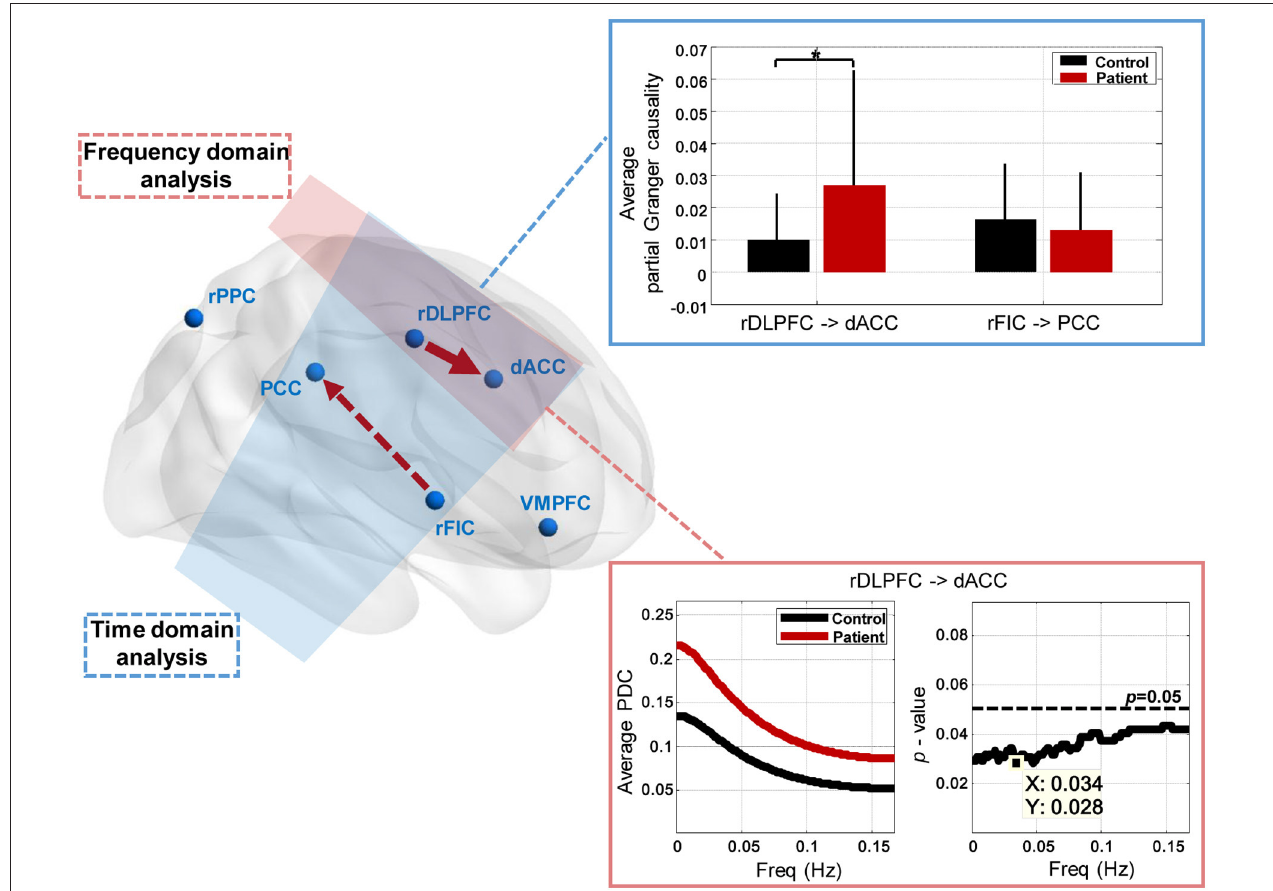
FIGURE 5 | Between-group effective connectivity differences. Two connections exhibit significant between-group difference revealed by Mann-Whitney U -tests in time domain analysis, including the increased connection from the rDLPFC to the dACC (* p < 0.05, FDR corrected), and the decreased connection from the rFIC to the PCC ( p < 0.05, uncorrected) in patients than healthy controls. The connections’ means and standard errors of partial Granger causality values across subjects within each group are illustrated in the blue box. Frequency domain analysis also reveals the enhanced connection from the rDLPFC to the dACC ( p < 0.05, FDR corrected) in patients. The mean partial directed coherence (PDC) values across subjects within each group, and the p -value spectrum are shown in the pink box.